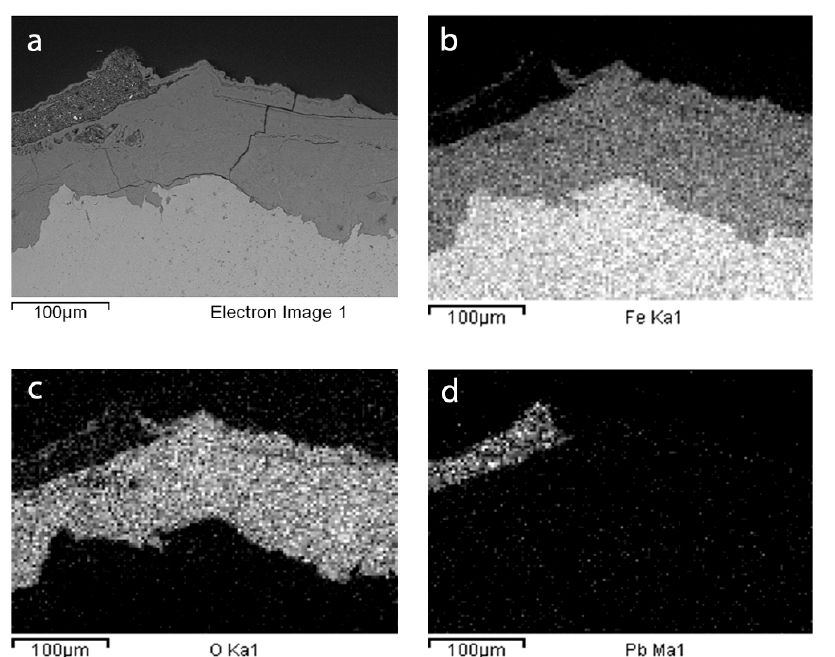
Figure 8. EDX maps of Sample 87 ( a ) Electron Image, ( b ) Iron Ka1, ( c ) Oxigen Ka1, and ( d ) Lead Ma1.